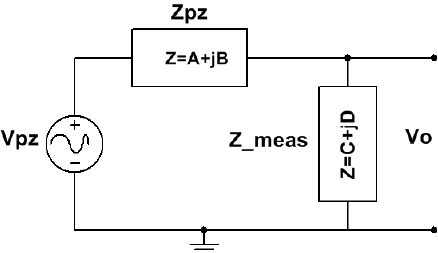
Figure 6. Electrical equivalent circuit needed to obtain the active piezoelectric model in energy harvesting road tra ffi c